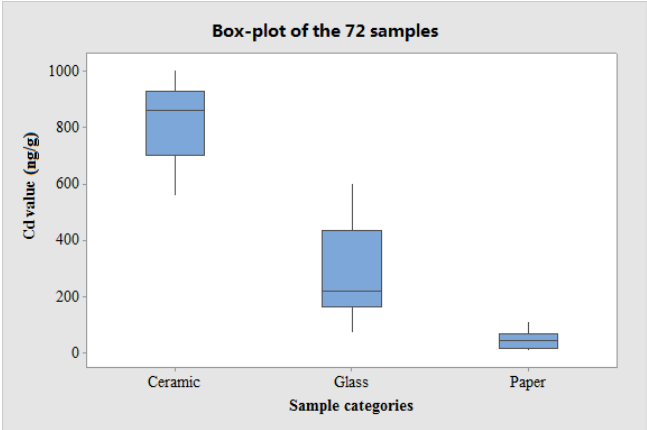
Figure 6. Box-plot of the 72 original samples (three categories, four samples per category and six replicates per